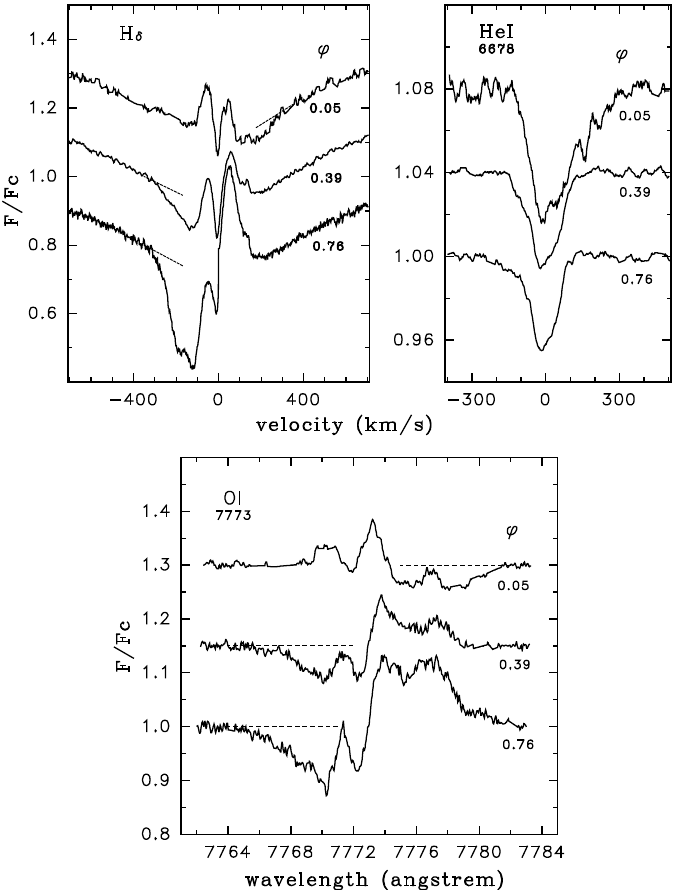
Figure 8. Profiles of the lines H δ , He I λ 6678 and OI λ 7773 observed in the spectra of HD259431 at the phases of 0.05, 0.39 and 0.76 of the period P = 2.839d. The initial phase ϕ = 0 corresponds to the epoch when the parameter V red (He I λ 5876) was